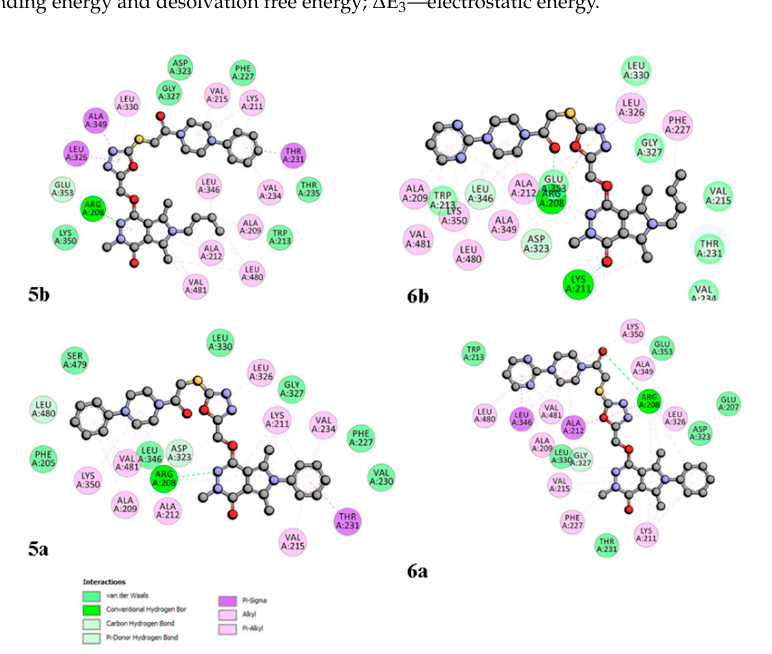
Figure 8. 2D interaction plot of 5a , 5b , 6a , 6b with BSA in the binding site II (subdomain IIIA). The interaction forces between a small molecule and protein include hydrogen bond, van der Waals force, electrostatic and hydrophobic interactions, etc. [47]. The thermodynamic parameters